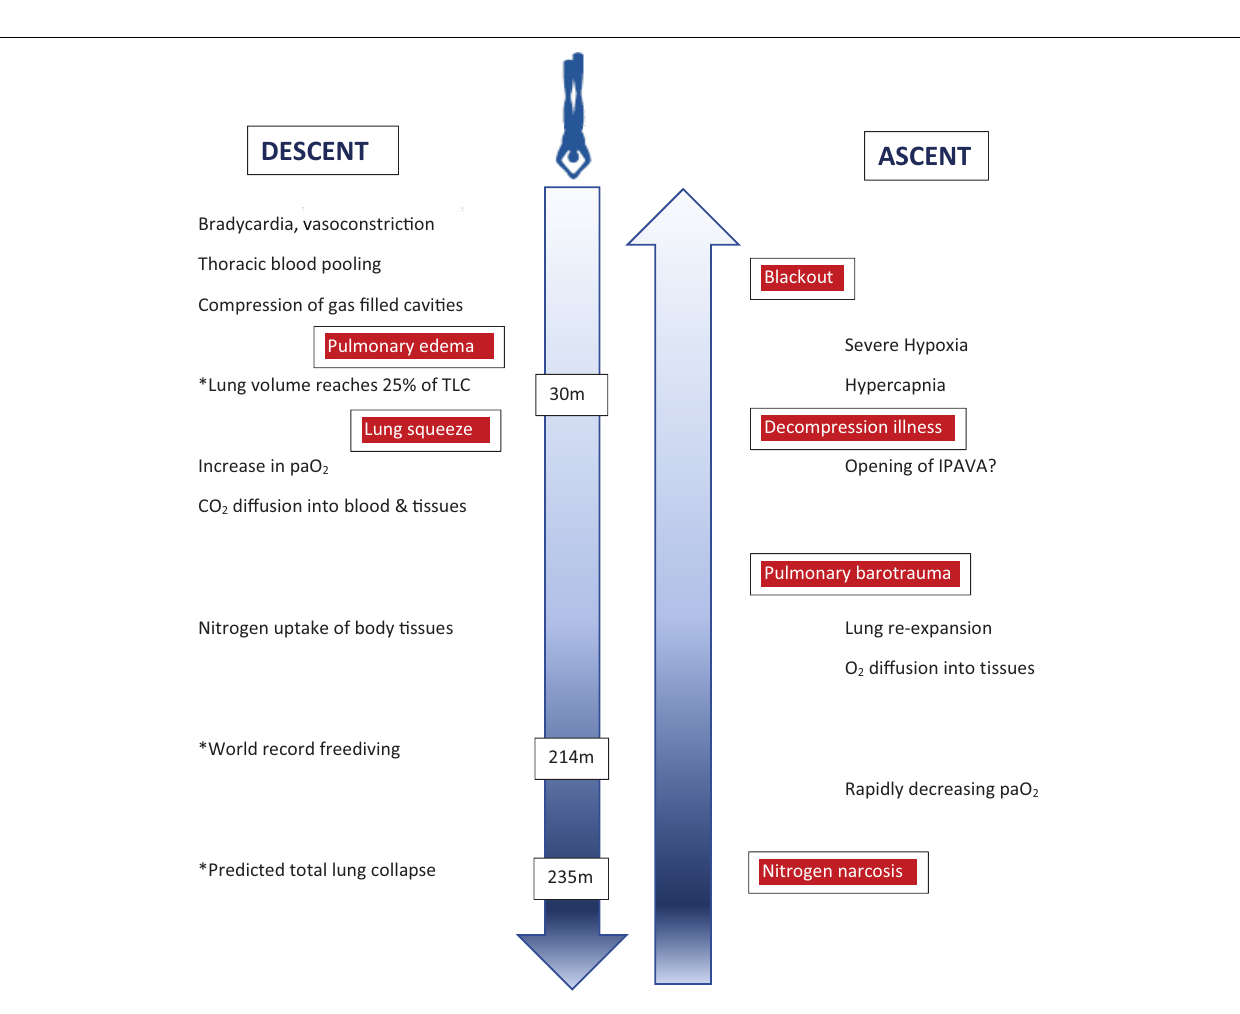
FIGURE 3 | Illustration of physiological changes and health risks (boxed red) during the descent and ascent of a deep breath-hold dive. Some examplary depths are marked ( ∗ ) to indicate critical physiological challenges or records achieved. Of note, health risks are not related to certain depths but rather depth ranges during descent or ascent, respectively. paO 2 = arterial oxygen pressure; IPAVA = intrapulmonary arteriovenous